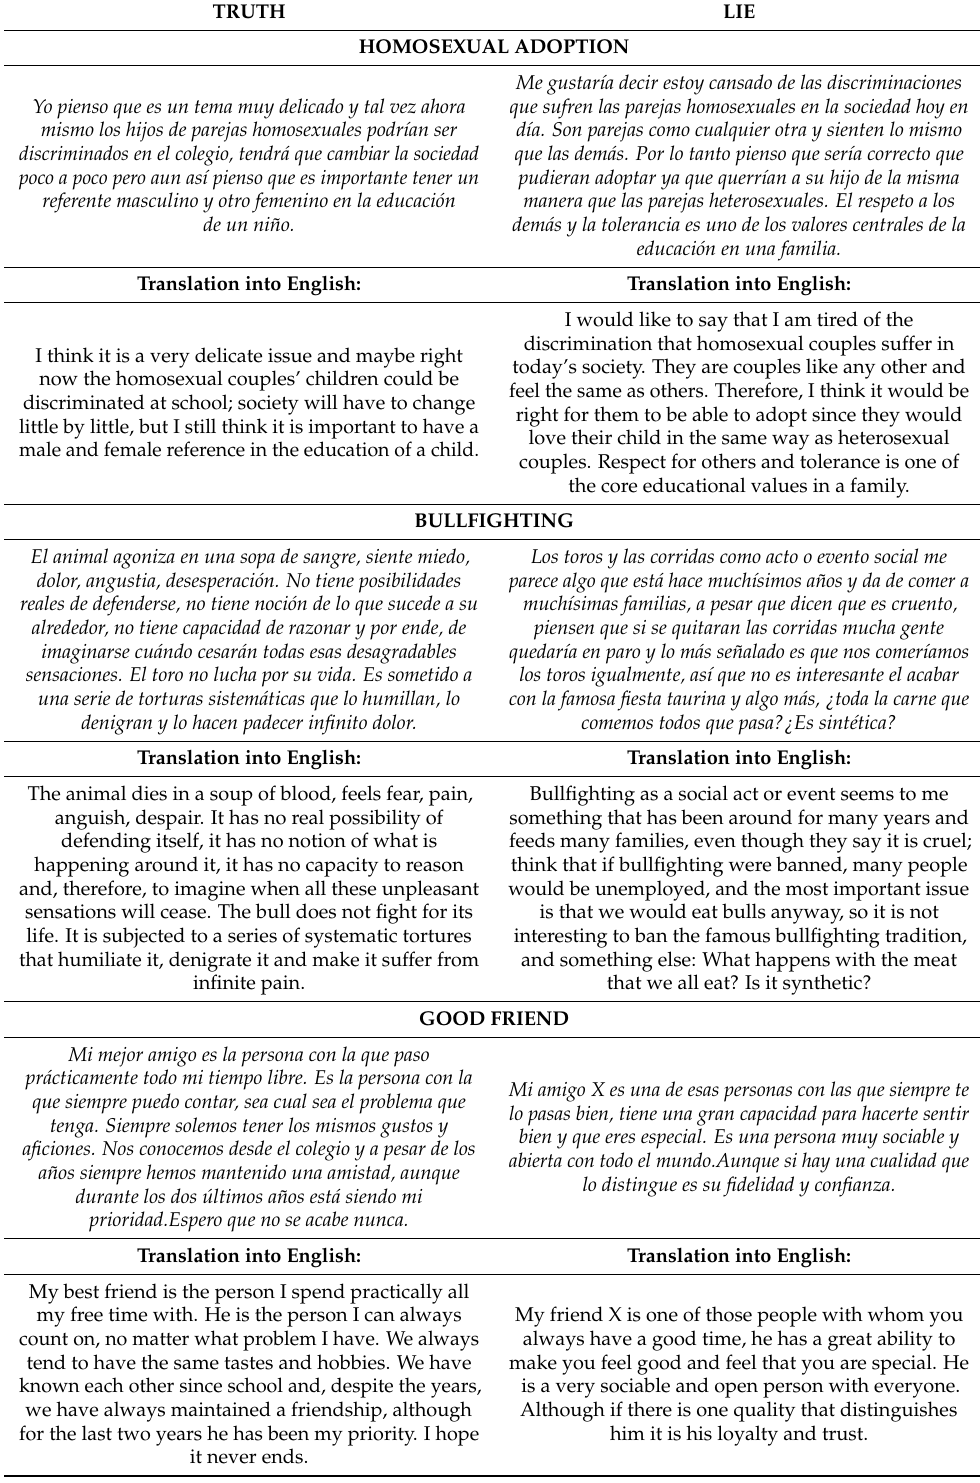
Table A4. Random sample 2 of truthful and untruthful statements in